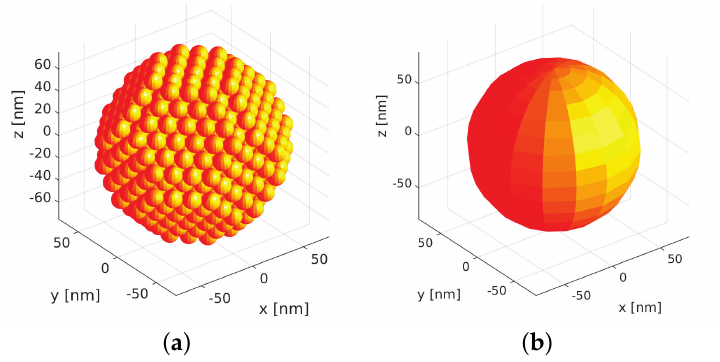
Figure 1. Cluster ( a ) composed of 675 spherical particles in fcc arrangement with nanocrystallite diameter d = 15 nm; Equivalent volume spherical particle ( b ) with diameter D = 145.5 nm.